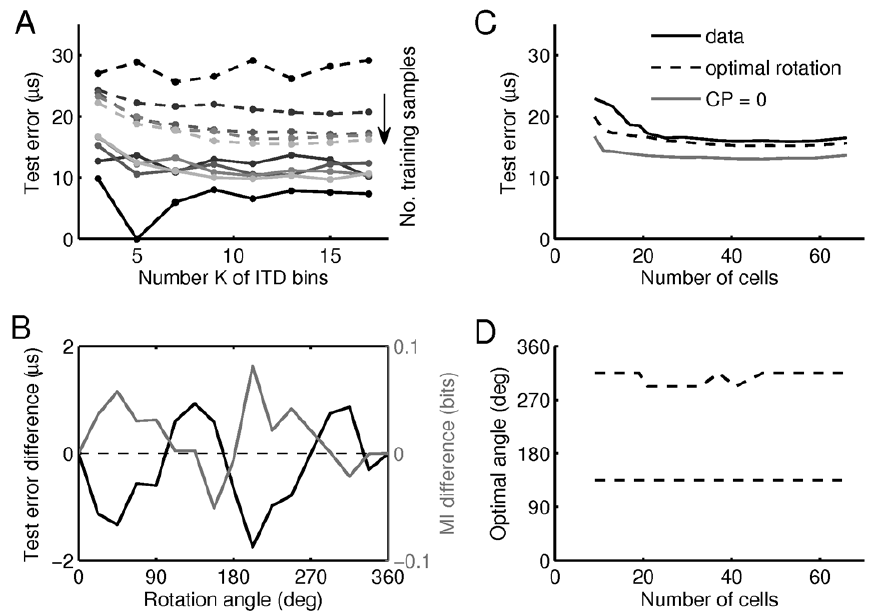
Figure 4. Linear separability of population patterns. (A) Test error as a function of the number K of classifications bins for five different numbers of training samples ( N ,3 N ,5 N ,7 N ,9 N as indicated by grey level). Training errors are plotted as solid lines, test errors (localization acuity) are plotted as dashed lines. (B) Difference in test errors (black) and single-cell mutual information (grey) as a function of the rotation angle. Positive differences indicate that the value obtained with the non-rotated CP-CD distribution is larger. For the linear classifiers, the number of training samples was 5 N . (C) Test error as a function of the number of input neurons for the actually measured CP-CD distribution (solid line), for the optimal rotation angle (dashed line), and for CP set to zero (grey). (D) Optimal rotation angles at which the test error difference from B has local